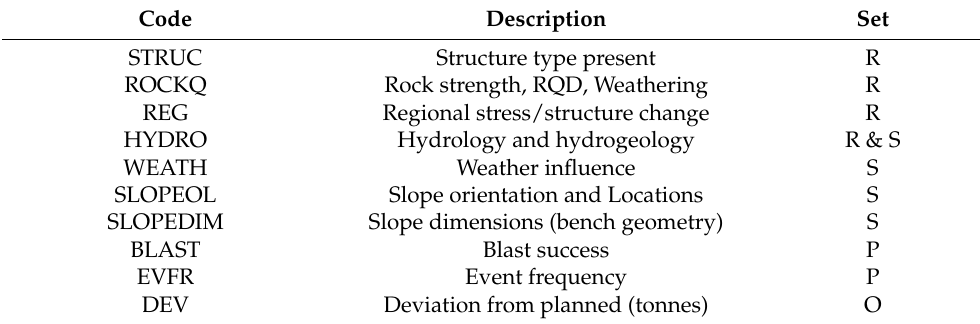
Table 4. Reduced parameter list used in initial RES matrix (R = rock, S = site, P = project engineering, O =